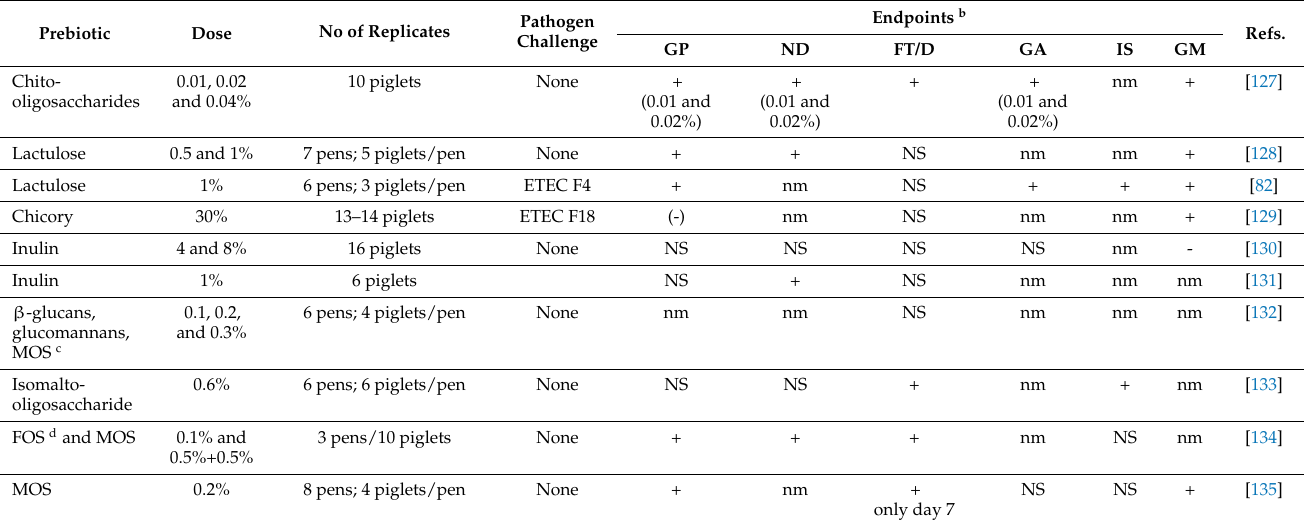
Table 3. Effects a of prebiotics on various parameters in